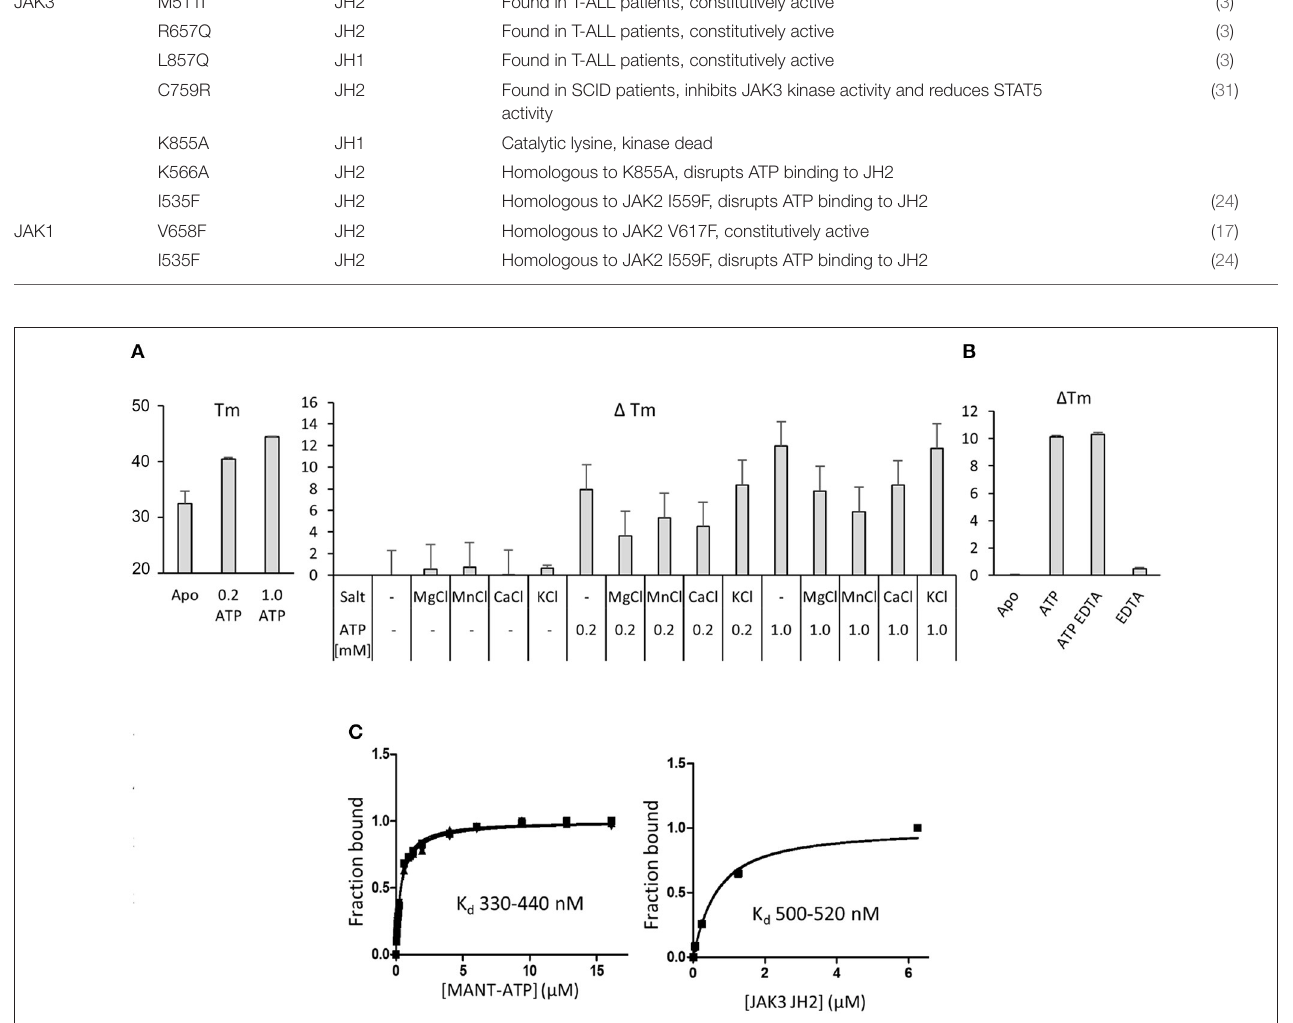
FIGURE 3 | Nucleotide binding to recombinant JAK3 JH2. (A) JAK3 JH2 binds ATP without cations. The effect of ATP on Tm of JAK3 JH2 is shown in the left panel. The following graph shows changes in the melting temperature ( 1 Tm) in JAK3 JH2 in the presence of different cations and ATP. (B) Chelating agent does not affect ATP-induced increase on Tm of JAK3 JH2. DSF analysis performed in the presence of ATP (1mM) and chelating agent EDTA (2mM). (C) MANT-ATP binding assay with recombinant JAK3 JH2. Both protein and MANT-ATP were titrated and both experiments gave similar Kd in the sub-micromolar range. Left panel: titrating MANT-ATP to 1.5 µ M JAK3-JH2. Kd range 330–440nM. Right panel: titrating JAK3 JH2 to 0.25 µ M MANT-ATP, Kd 500nM. Protein concentrations were 0; 0.05; 0.25; 1.25 and 6.25 µ M. In both figures, the Y-axis is the fraction of ligand-bound protein in relation to the total protein amount ([PL/Ptot]). The MANT-ATP titration was repeated three times and all experiments are plotted in the lower left panel. Protein titration was repeated twice and both experiments are blotted in the